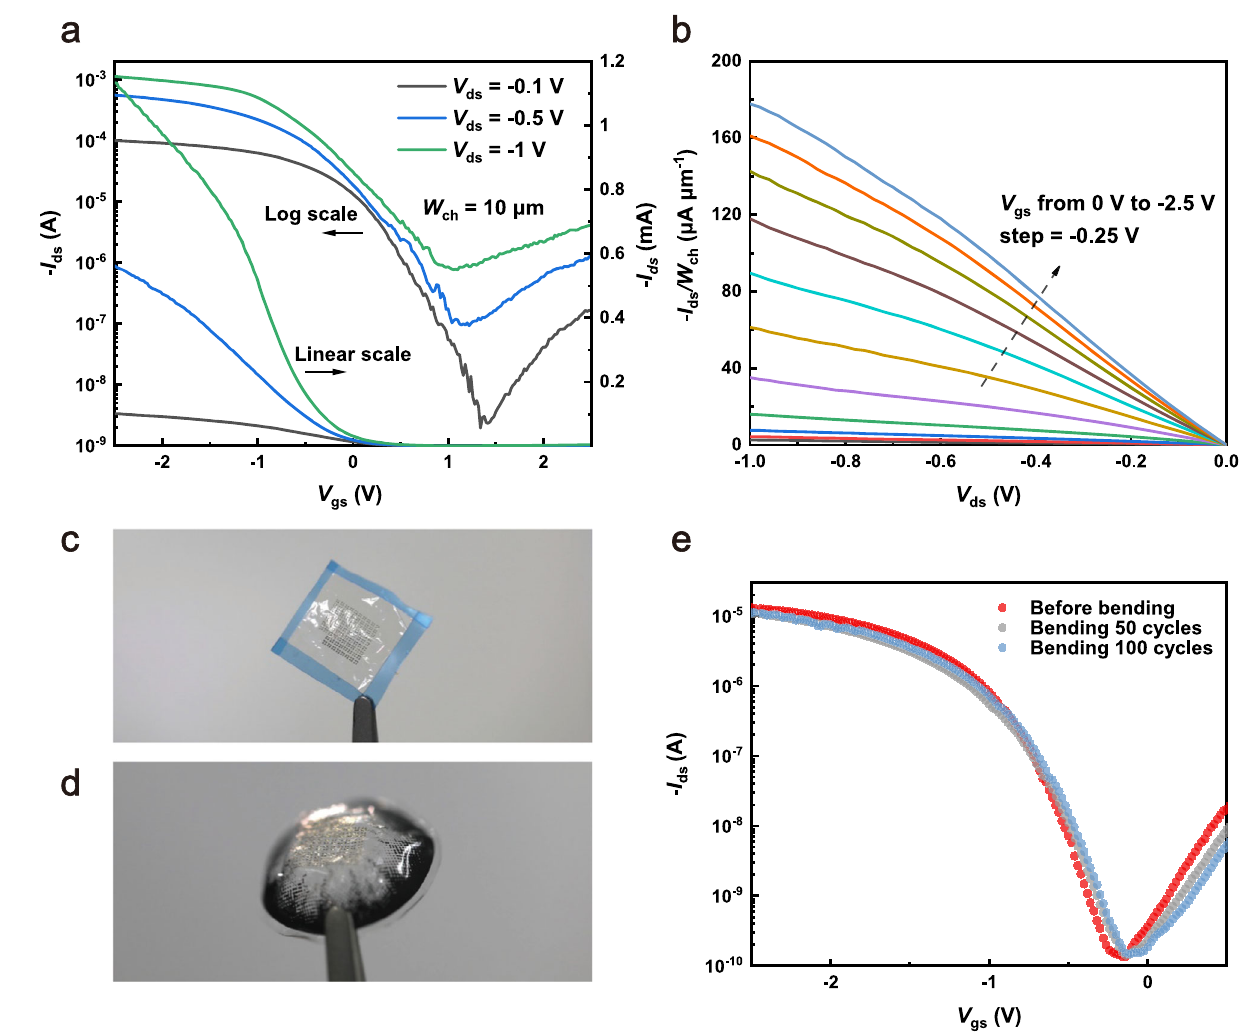
Fig. 2 | Characterization of fl exible CNT-TFTs. a Transfer characteristics of a representative fl exible CNT-TFT with L ch =450nm under different V ds biases. b Output characteristic of the representative CNT-TFT with L ch =450nm.